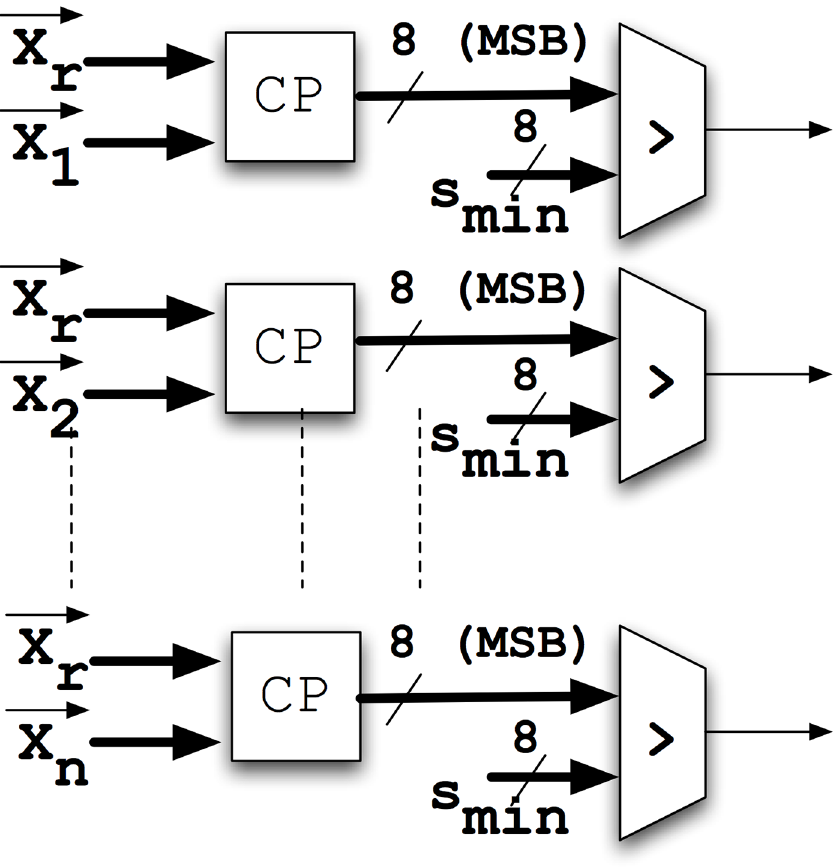
Fig 17. Global comparator between the reference vector and each vector in the database. Block CP is implementing the circuitry shown in Fig 16. The result is compared with s min .